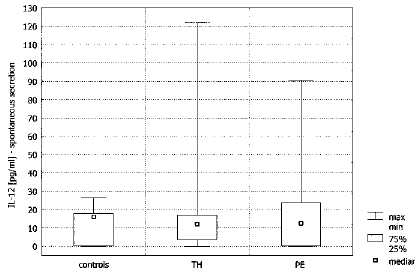
FIG. 1. Comparison of IL-6 spontaneous secretion in healthy pregnant women (controls) ( n = 11), and pregnant women with transient hypertension (TH) ( n = 17) and pre-eclampsia (PE) ( n = 21). Statistically significant are the differences between controls and PE ( p < 0.002) and between TH and PE ( p < 0.0008).